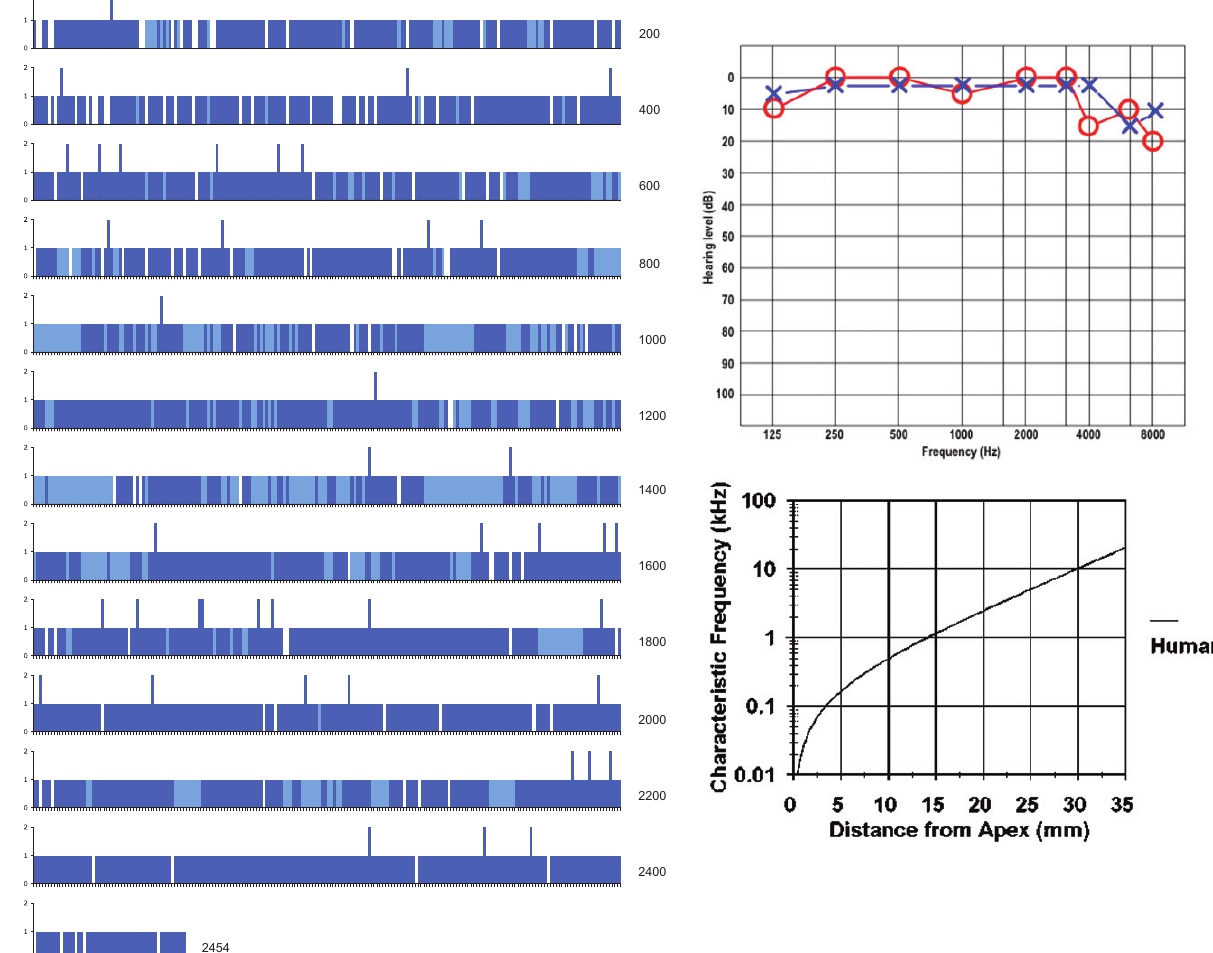
Figure 5. Missing IHCs (white bars) and sIHCs (blue bars). Light blue areas depict regions that are difficult to evaluate. The Greenwood place/frequency scale shows the characteristic frequencies (Hz) as the distance from the